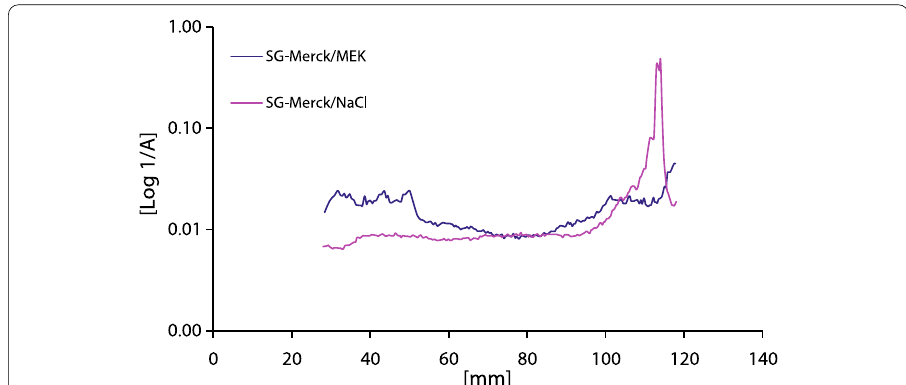
Fig. 3 Distribution of glucose on a TLC of the hydrophilic fraction of [ 99m Tc]Tc-NanoHSA. [ 99m Tc]Tc-NanoHSA from one radiolabelling was retained on a Sep-Pak ® cartridge and hydrophilic fraction A was submitted to TLC. Glucose migrated with the solvent front in 0.9% NaCl (purple trace) and mostly remained at the start in MEK (blue trace) mobile